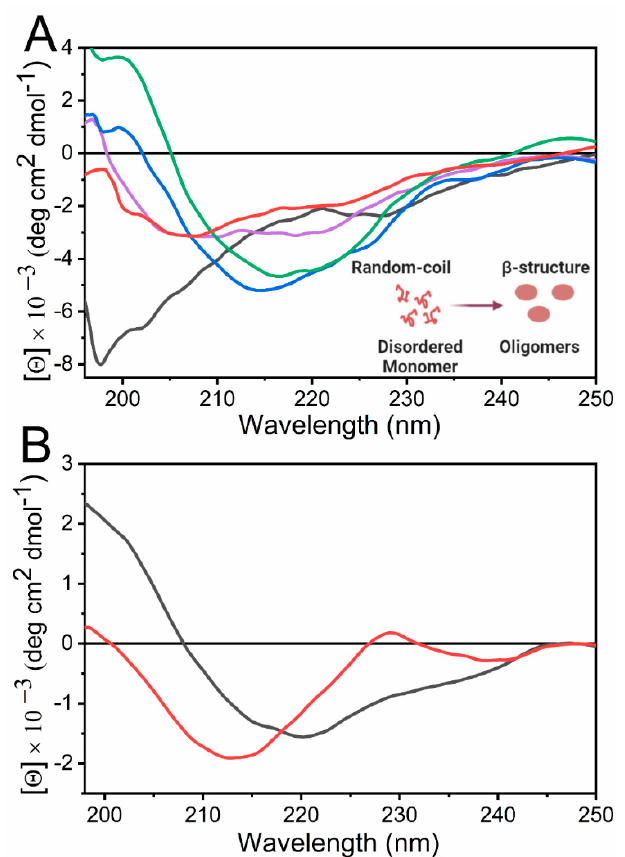
Figure 11. Circular Dichroism as a tool for the study of protein self-association. ( A ) Experimental spectral analysis of the oligomerization of the αβ -amyloid peptide overtime under physiologically relevant conditions. In 0 (black), 0.5 (red), 1 (violet) 3 (blue) and 7 h (green). This image was extracted and re-created from Tonali et al. [104]. ( B ) Spectra showing the structural transformation of the 33-mer gliadin peptide at 613 µ M depending the temperature, at − 5 ◦ C (red) corresponds to PPII structure and at 37 ◦ C (black) to the β -sheet signature. Image re-created from Herrera et al. [48] .